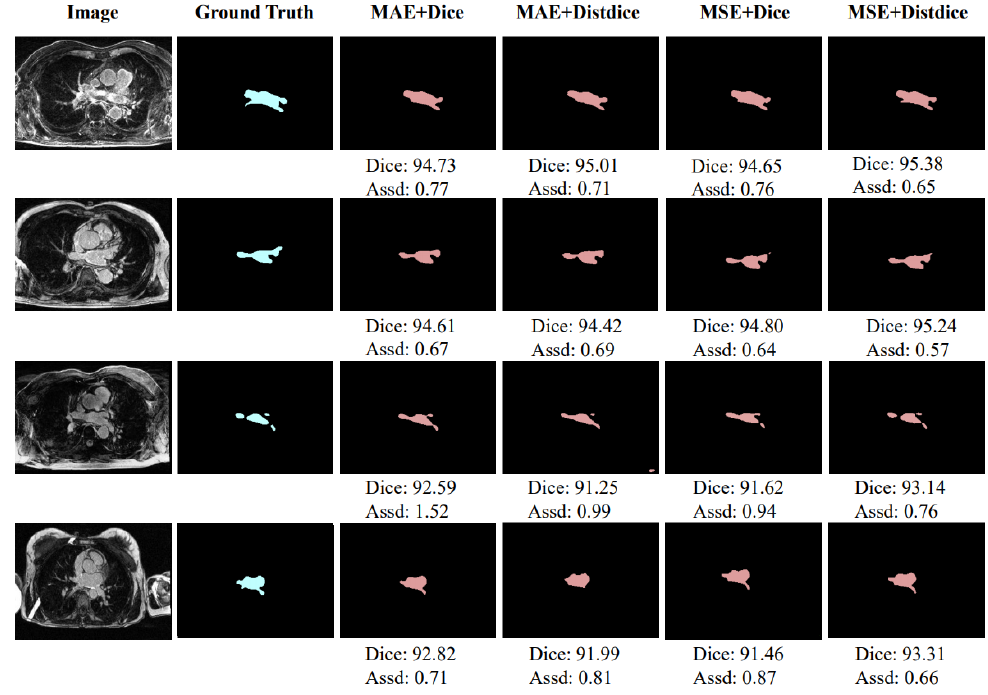
Figure 6. Exemplar segmentation results using different combination loss